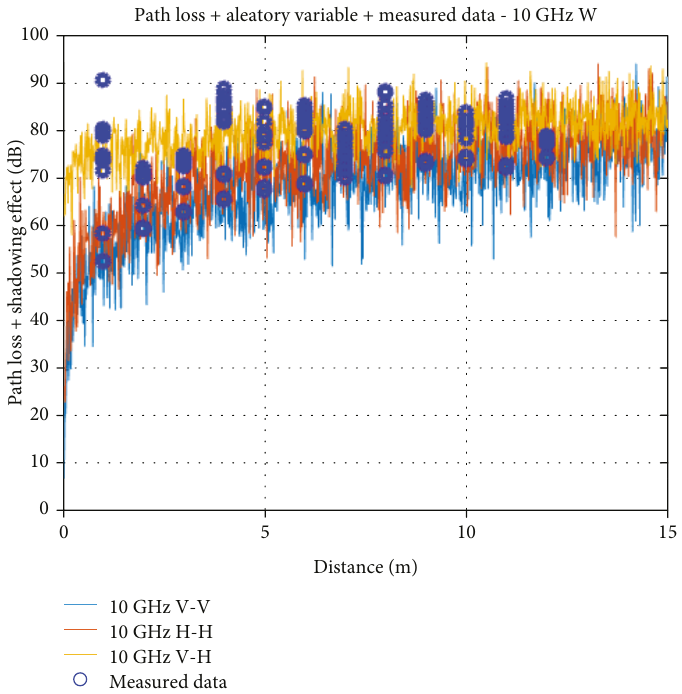
Figure 7: Path loss model CI with shadowing e ff ect at measured data for 10 GHz band in laboratory scenario. Standard deviation point to point for 10 GHz V-V, H-H and V-H 6